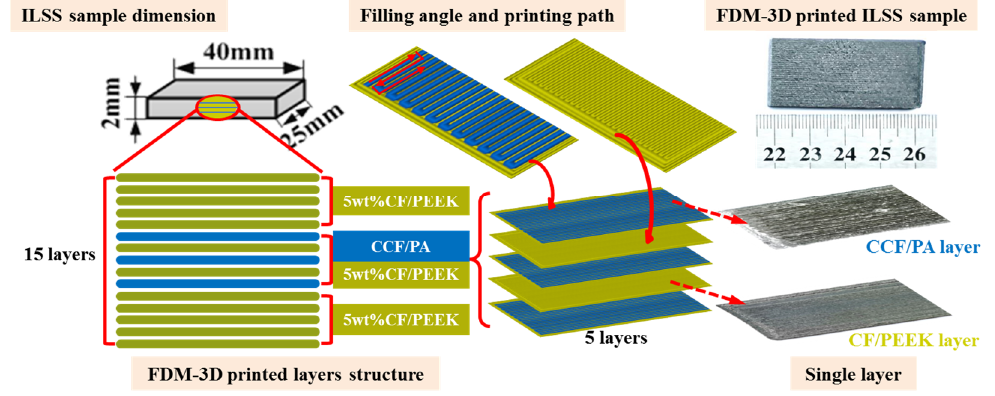
Figure 2. FDM 3D-printed ILSS sample dimension, filling method and layer structure.